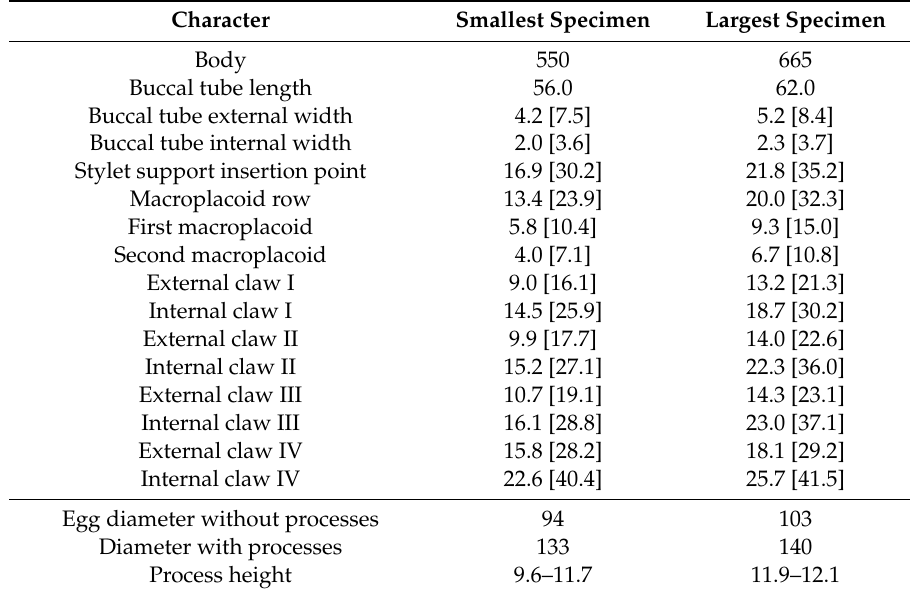
Figure 2. Diaforobiotus islandicus islandicus : ( A ) Habitus, ( B ) bucco-pharyngeal apparatus (lateral view), ( C ) claws of legs IV with large dentate lunula, ( D ) egg shell (midsection); using phase contrast microscopy. Table 1. Measurements of selected morphological characters of largest and smallest specimens of Dia. i. islandicus and eggs (all values in µm, pt ratios in brackets).